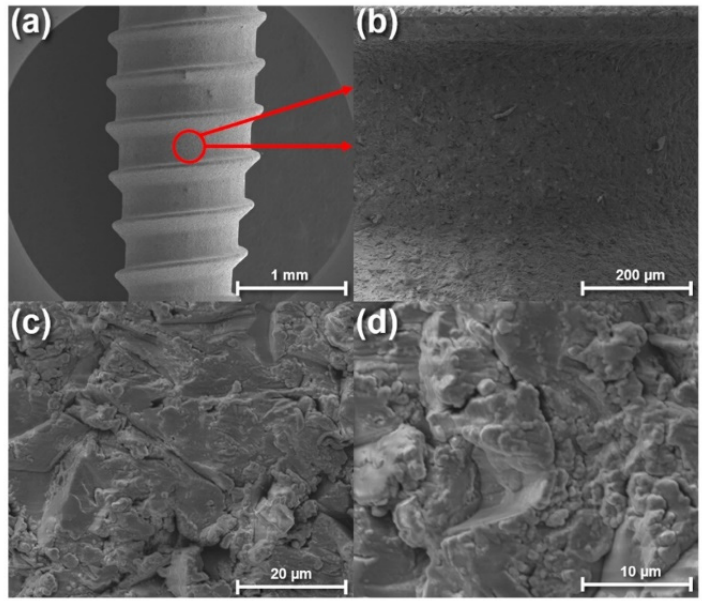
Figure 15. Scanning electron microscope images of a SiC-coated titanium implant at various magni- fications. Image ( a ) shows the overall surface of the implant, whereas images ( b – d ) show detailed images of the implant surface morphology at increasing magnifications [47].